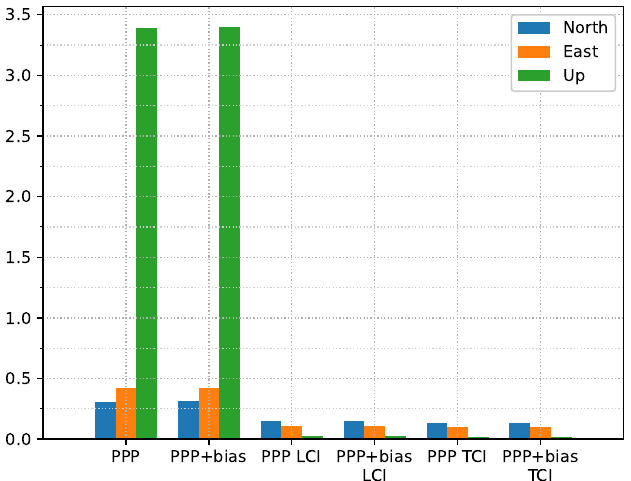
Figure 23. Velocity error RMS of real-time GPS/Galileo PPP/INS results of road bridge test on 11 February